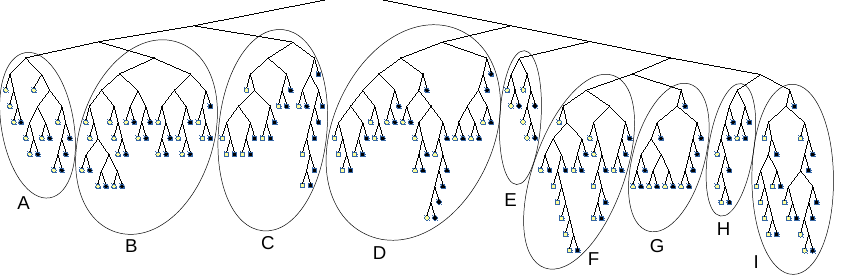
Figure 10. Structure of the model. Small circles correspond to the tree final nodes (also called leaves): light ones are classified as clear sky, and dark ones as cloudy. The parts circled and labelled with letters correspond to the groups of points defined in Table 2.